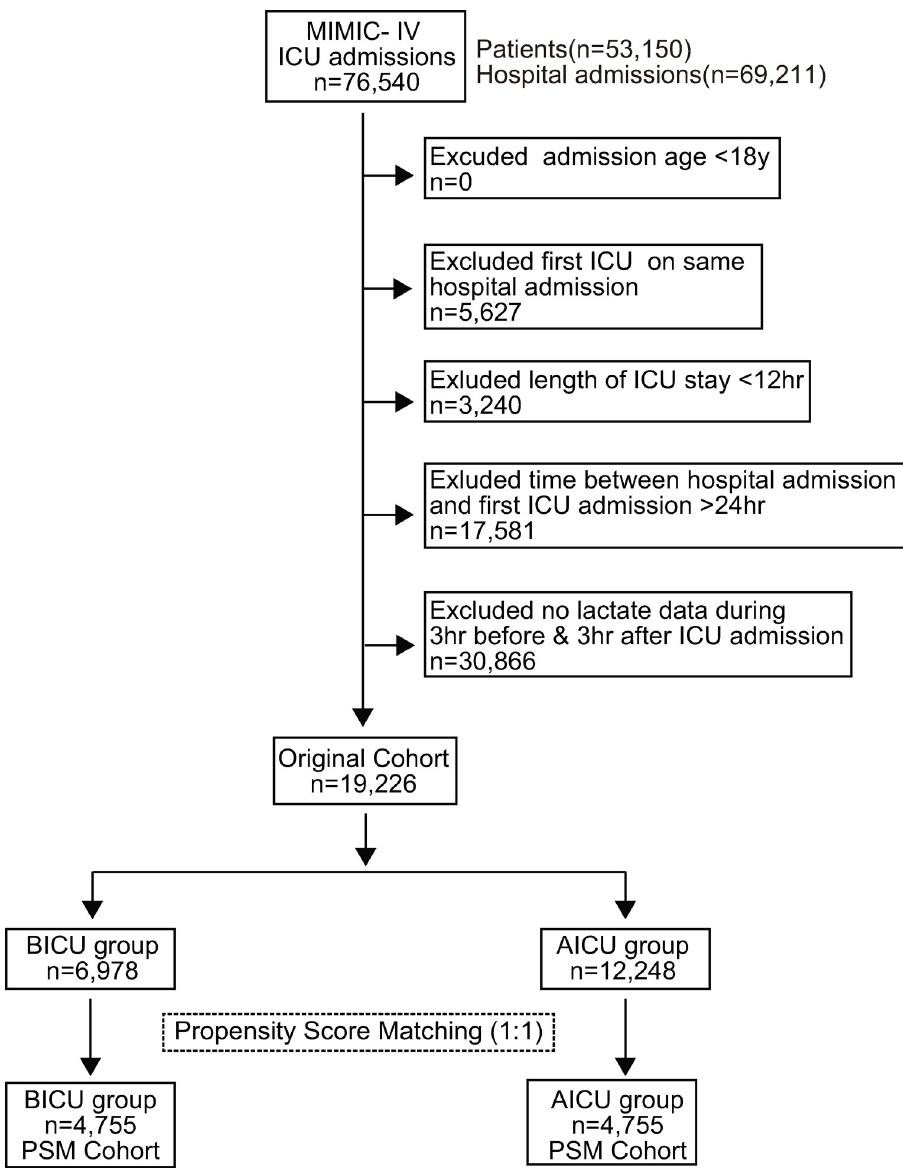
Fig 1. Flow diagram of study